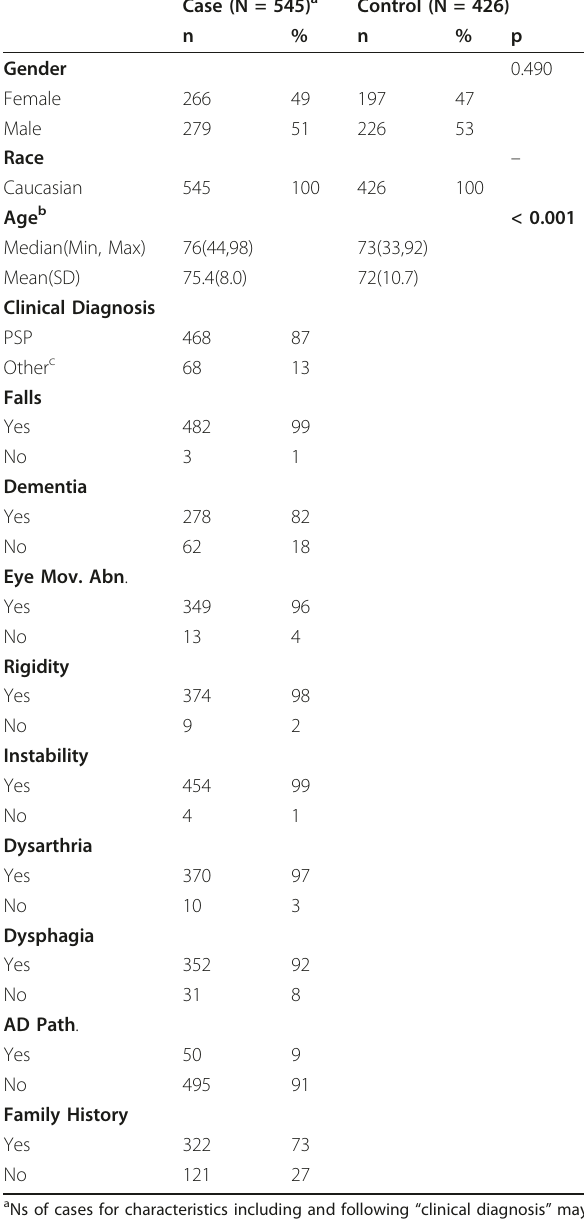
Table 1 Characteristics of PSP Cases and